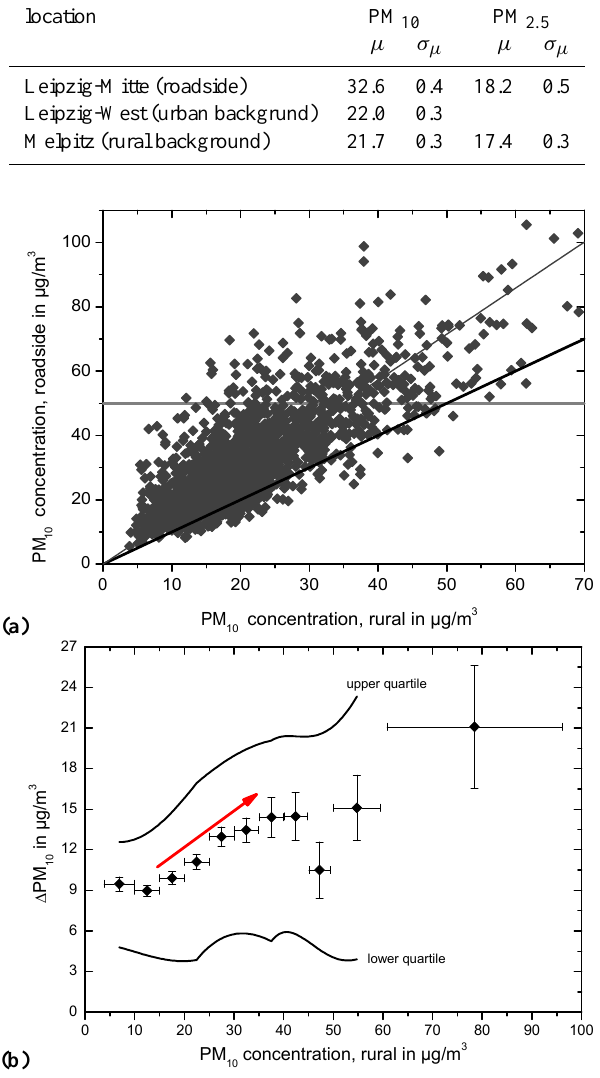
Fig. 3. Comparison between rural PM 10 , roadside PM 10 and the roadside increment 1 PM 10 , 2005–2009. In (a) the daily limit value of 50µgm − 3 is indicated by a horizontal line. A linear fit through the origin yields a slope of 1.43 ( R 2 = 0 . 62). In (b) data were aver- aged over bins of rural PM 10 indicated by x-axis whiskers. Y-axis whiskers indicate the standard error of the mean. The range of a multiplicative effect in the roadside increment 1 PM 10 is indicated by a red arrow.